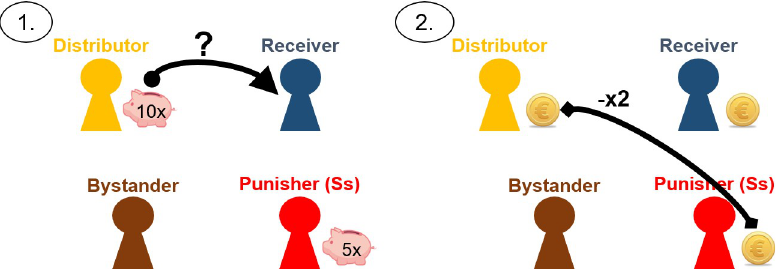
Fig 1. Overall structure of the economic game. Each round consisted of two steps. Initially, the distributor started with 10 piggy banks and the punisher started with five piggy banks. Each of these piggy banks contained a random number of valuable coins. (1) In step 1, the distributor decided how many of their own piggy banks should be given to the receiver. (2) In step 2, the punisher opened all piggy banks and counted the number of coins. Subsequently, the punisher had the power to reduce the distributor’s payoff by investing own coins; each coin spent resulted in a reduction of two coins for the distributor.